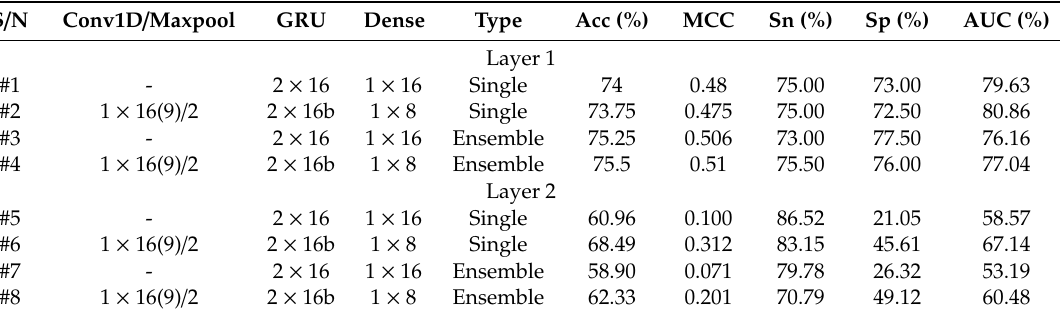
Table 7. Independent test